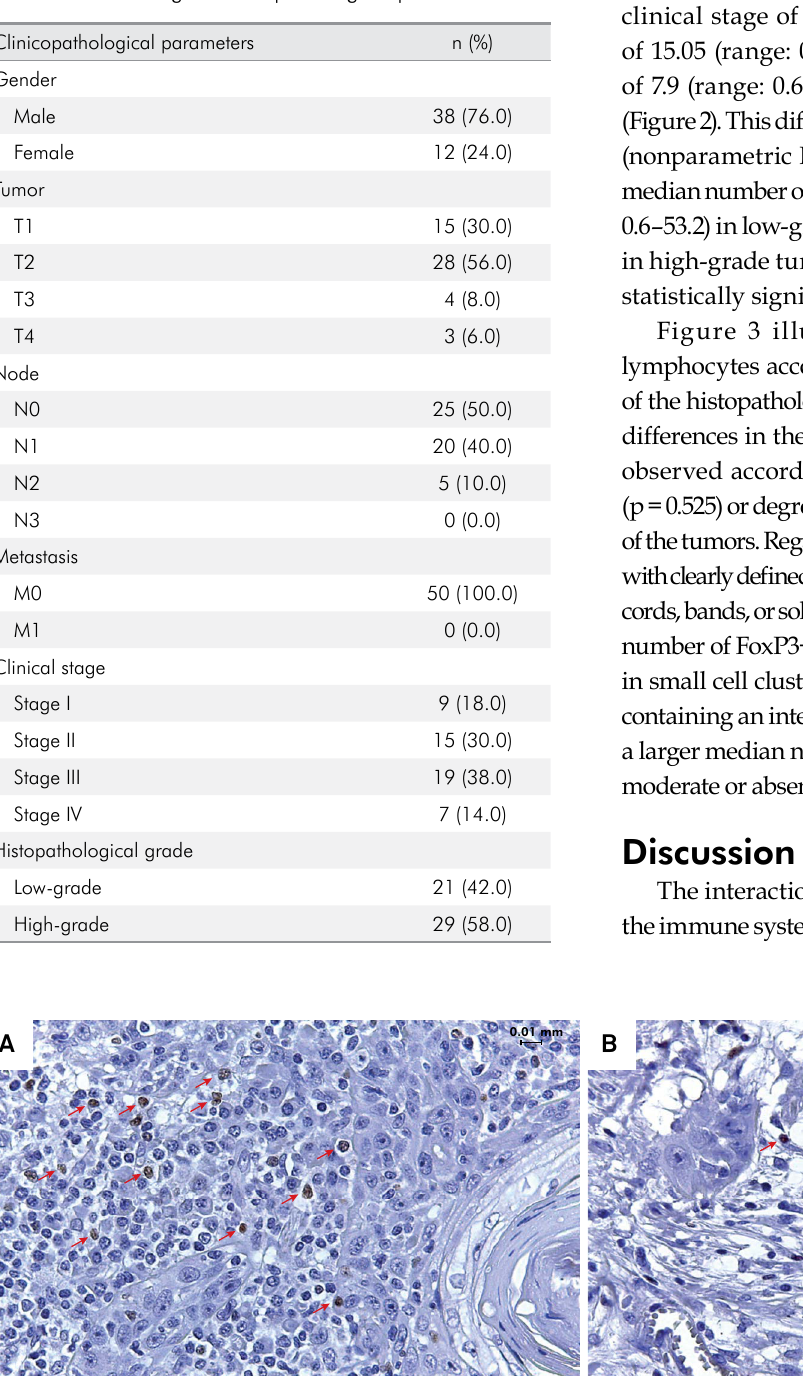
Table. Distribution of cases of lower lip squamous cell carcinoma according to clinicopathological